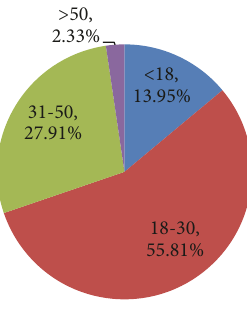
Figure 2: Age range. Figure 3: Access type.